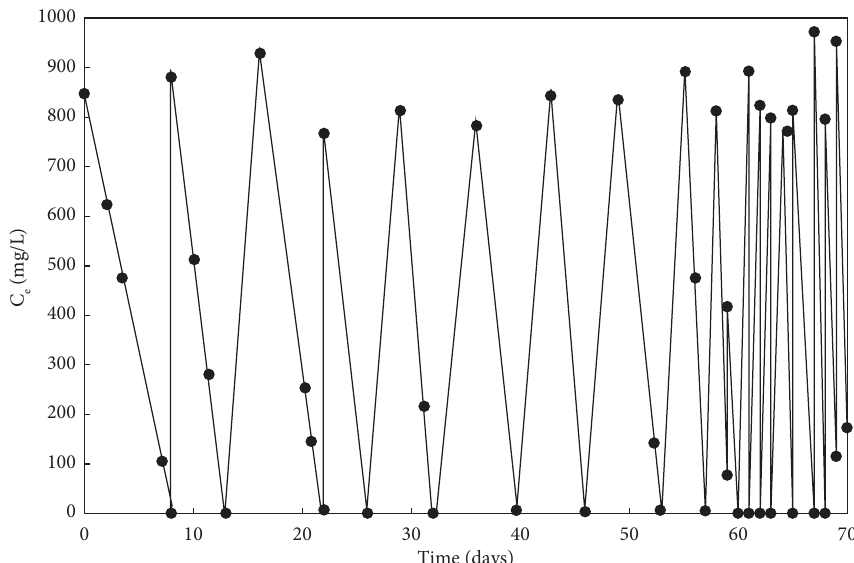
Figure 2: Biological removal of perchlorate by EMC during enrichment. Te conditions were: perchlorate feed � 800mg/L; yeast � 2g/L; pH � 7.0 ± 0.5; and T � 25 ° C. A few data points were omitted when sludge conditions were not Table 2: Perchlorate removal during EMC enrichment and during the establishment of steady-state removal. Stage cycle date